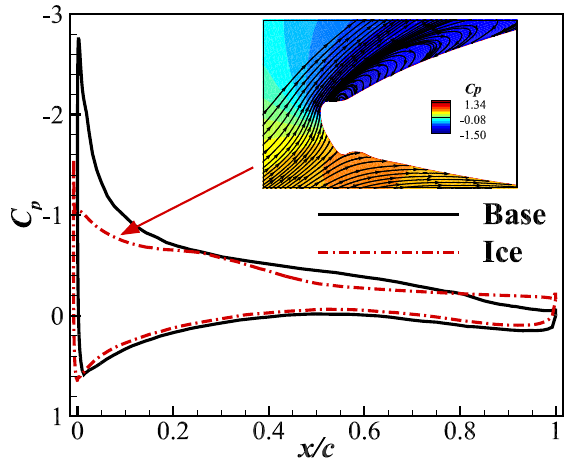
Figure 6. Pressure distribution and streamline changes at y / b = 0.95.